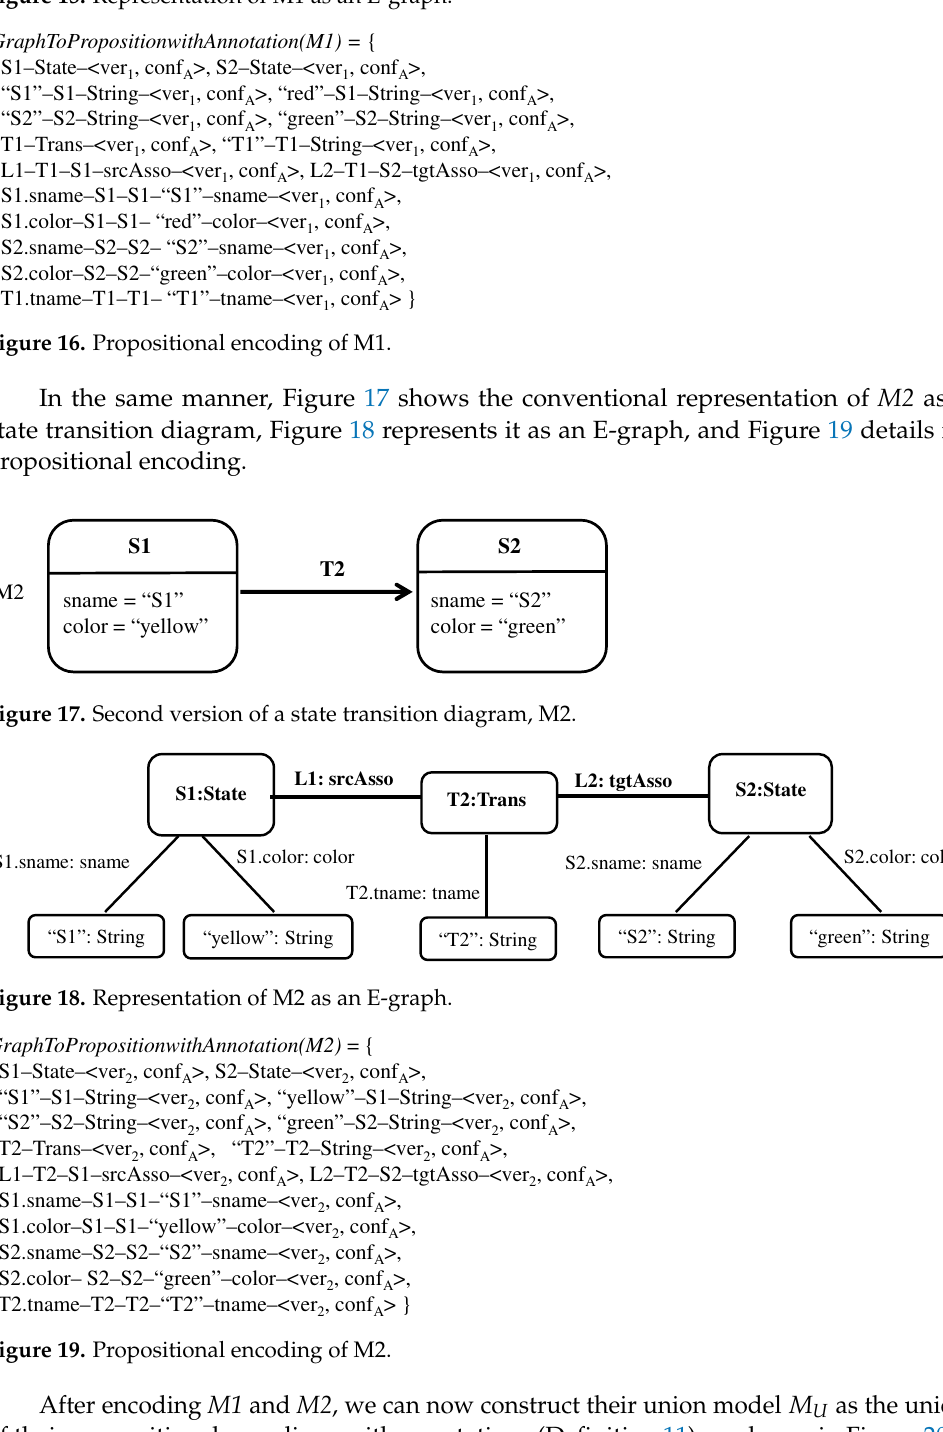
Figure 15. Representation of M1 as an E-graph.